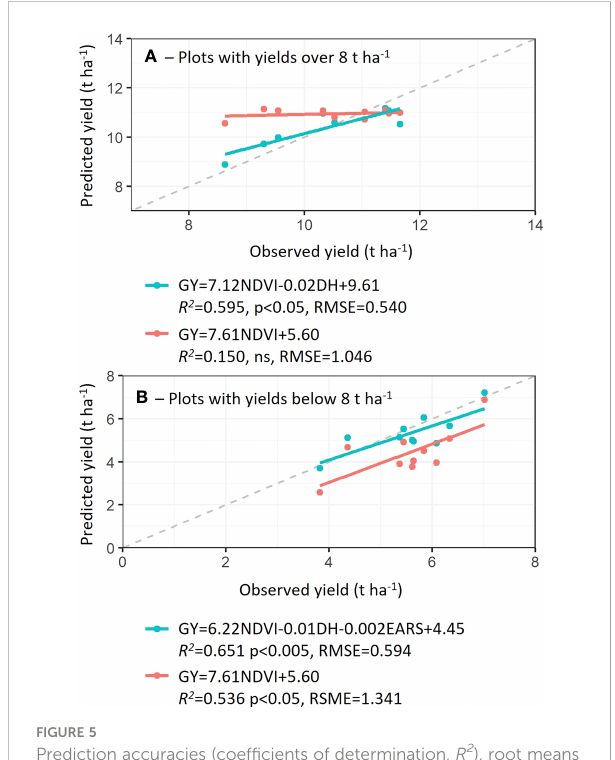
FIGURE 5 Prediction accuracies (coef fi cients of determination, R 2 ), root means square root (RMSE) and probability of models developed with 50 data points from Case Study 2 using plots with yields over and below 8 t ha -1 (A, B) , respectively. Predicted yield values were calculated in 10 plots not used in the development of models (rainfed and late sowing). Dashed line indicates a 1:1